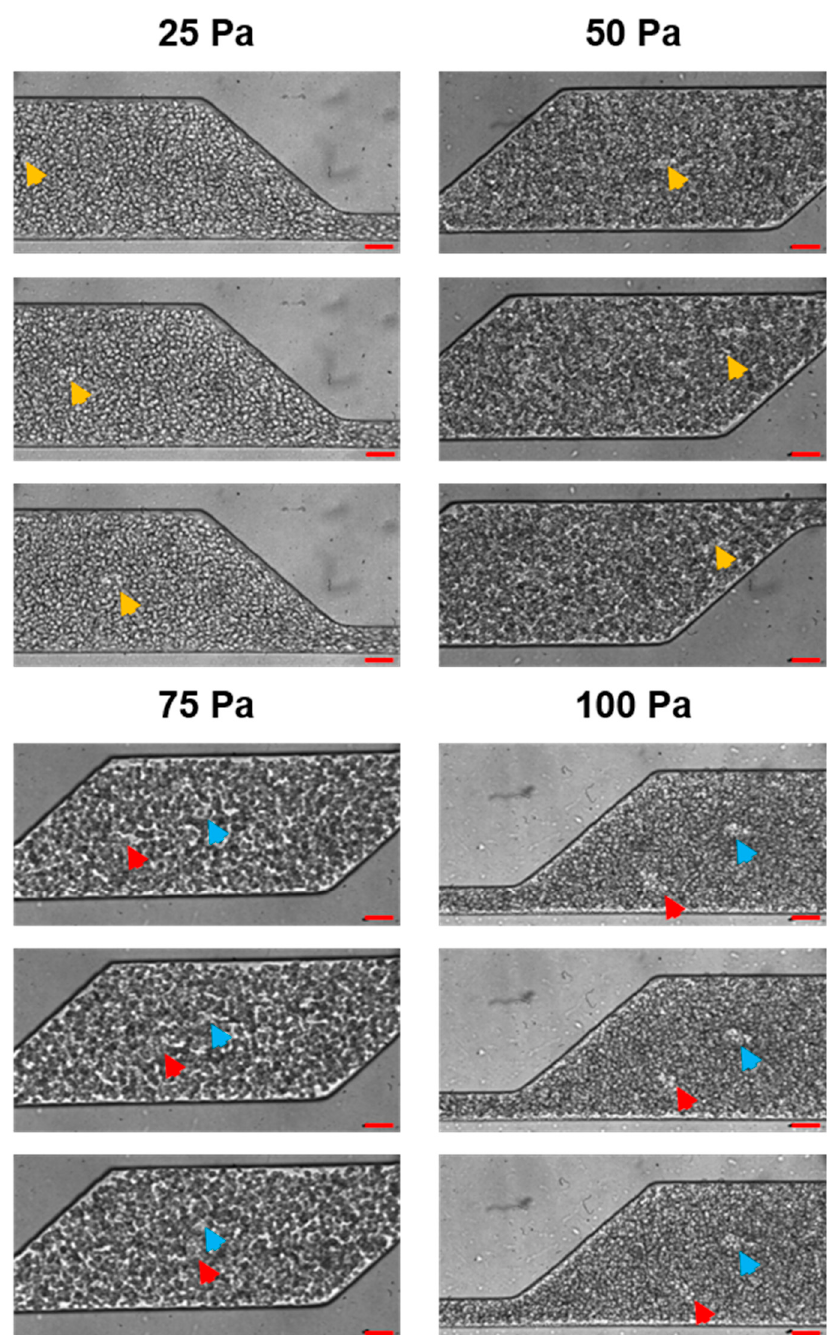
Figure 4. Migration rate and aggregation of damaged erythrocyte in microfluidic devices. All the blood samples were subjected to each shear stress environment for 10 min. The initial flow rate injected into devices was 0.12 mL/min. With the increase of shear stress, the blood cell migration rate declined, but the aggregation increased. Yellow arrow: erythrocyte; Blue arrow: adhesion thrombus; Red arrow: moving thrombus (scale bar: 20 μ m).